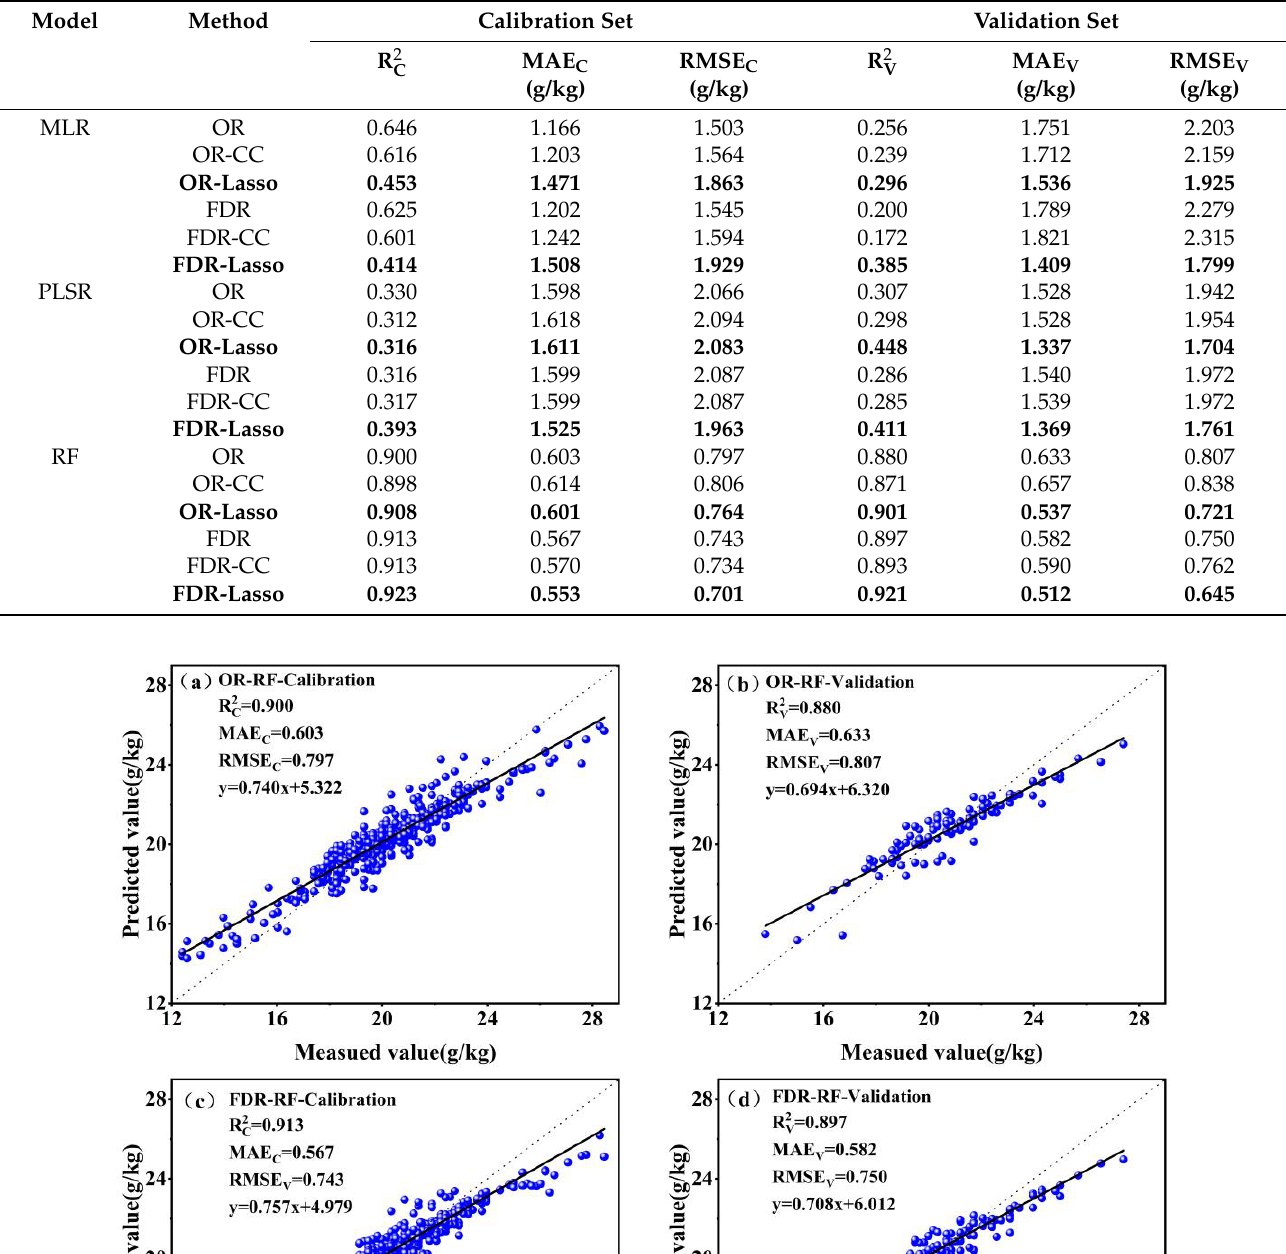
Table 5. The prediction model’s outcome statistics.